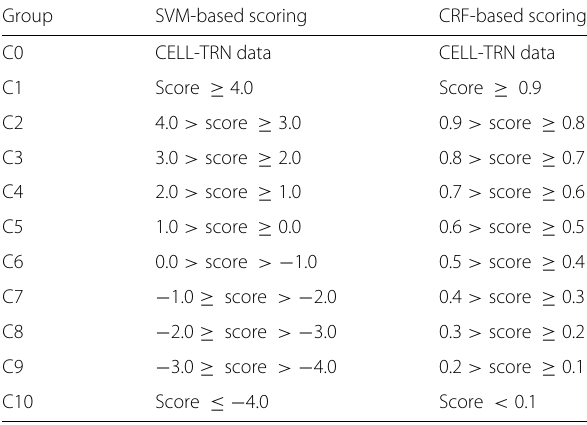
Table 5 The organized groups of SVM- and CRF-based scoring calculated from Twitter text